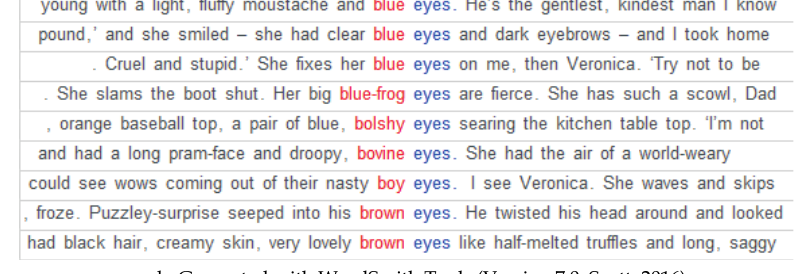
Figure 3. A section of concordance list for the word “eyes” in Crystal Jeans’s Vegeterian Tigers of